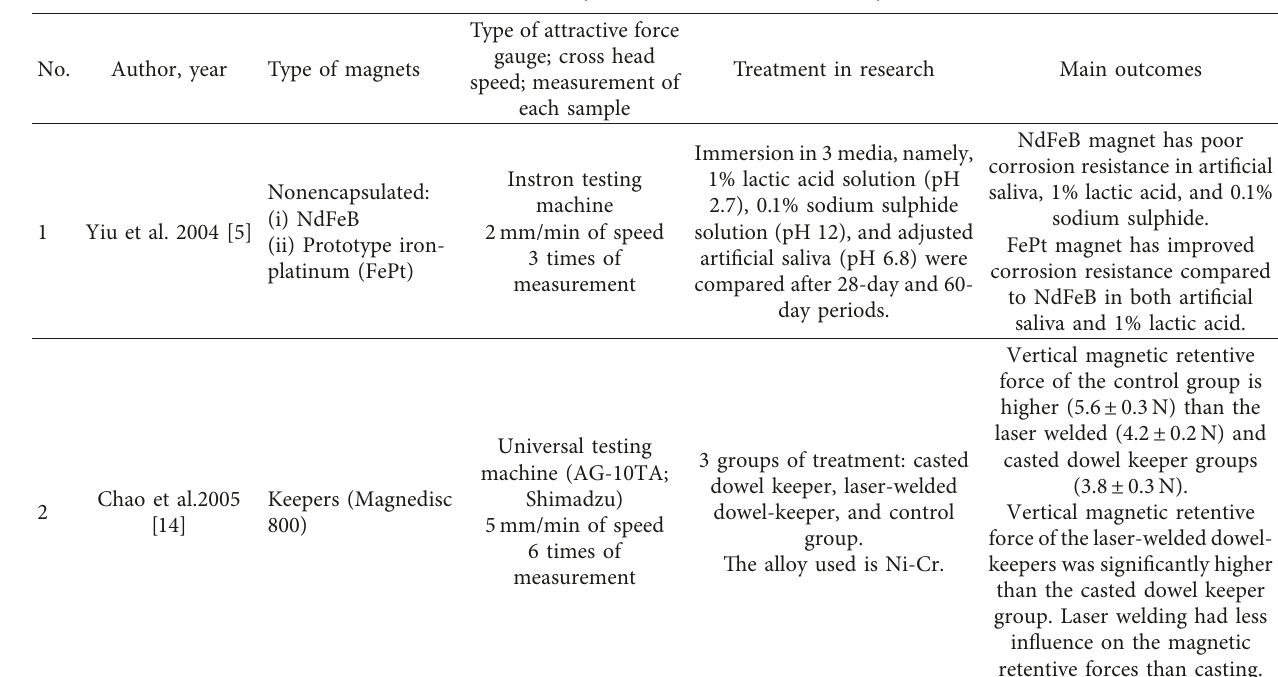
Figure 1: Selection procedures according to the PRISMA Table 1: Summary of characteristics of each study.